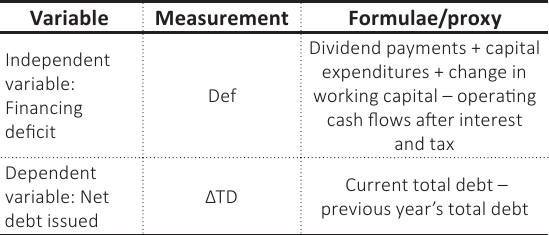
Table 1. Variables and measures: Pecking order